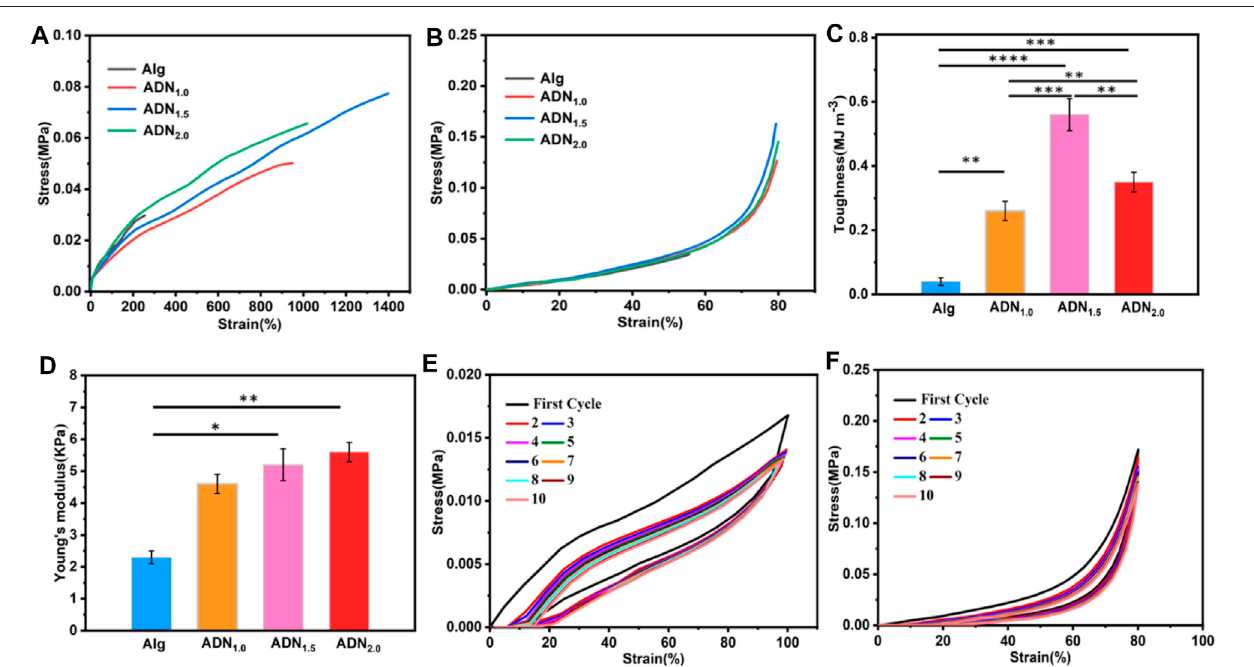
FIGURE 3 | Mechanical properties of the ADN hydrogels. (A) Tensile strain vs. stress curves of the ADN hydrogels. (B) Compressive strain vs. stress curves of the hydrogelsat80%strain.Toughness (C) andYoung ’ smodulus (D) ofthehydrogels. (E) Tensuccessivecyclictensileloading − unloadingcurvesoftheADN 1.5 hydrogelat 100% strain. (F) Ten successive cyclic compressive tests of the ADN 1.5 hydrogel at 80% strain. **** p < 0.0001, *** p < 0.001, ** p < 0.01, * p <